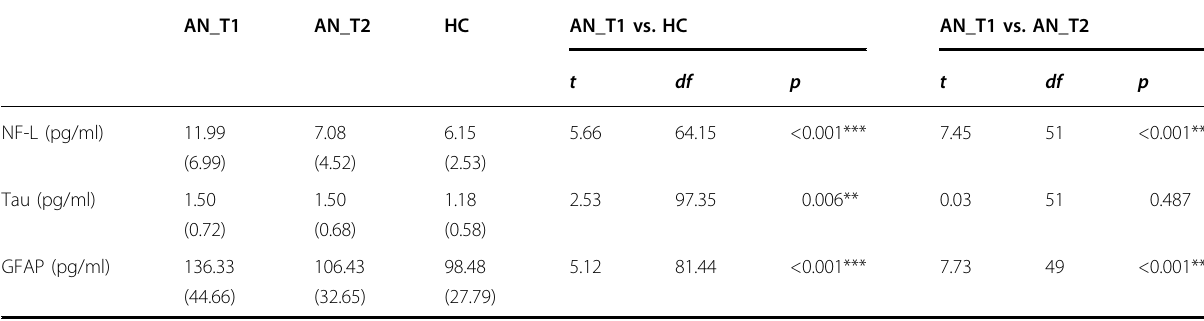
Table 2 Mean values (standard deviation) of brain-derived protein marker concentrations and statistics of group